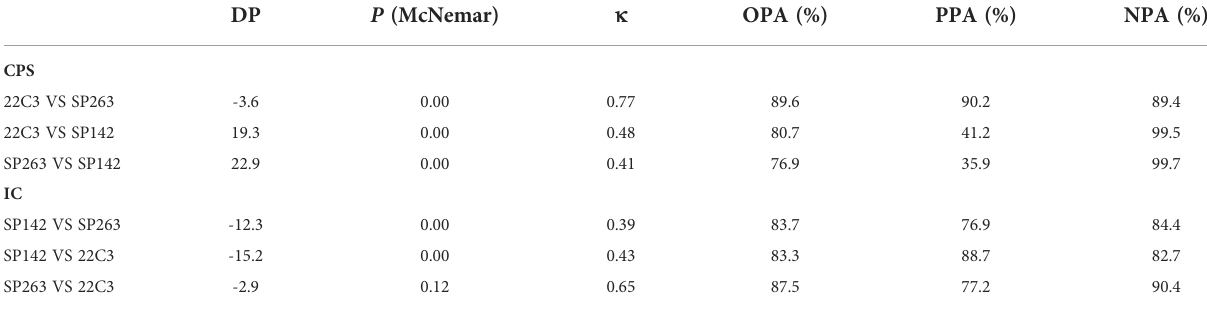
TABLE 3 Comparison between assays 22C3, SP263, and SP142 according to different scoring algorithms. DP P